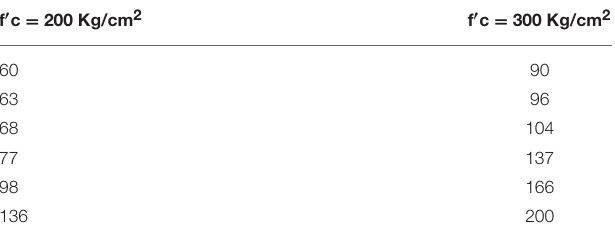
TABLE 3 | Initial costs for scenario seismic ground accelerations (million USD).